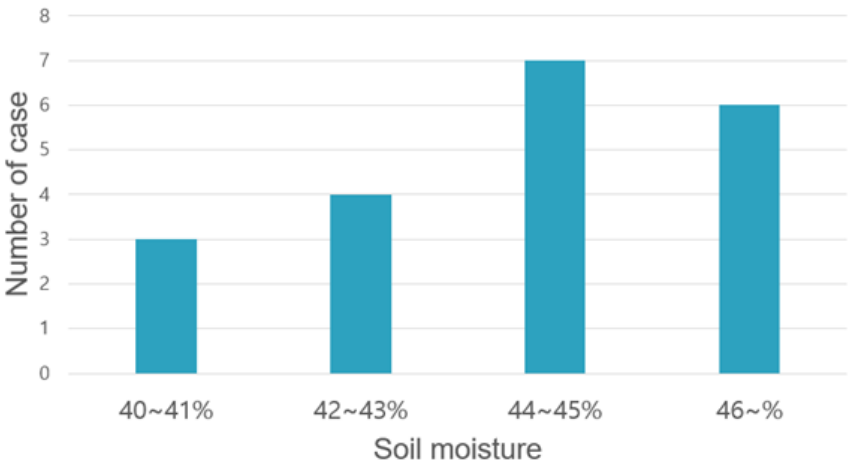
Figure 18. Soil moisture sensing value reflecting actuator’s action in cloud level closed-loop control.